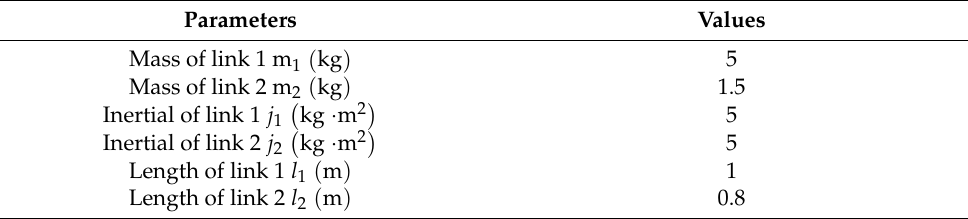
Table 1. Parameter of the robotic manipulator. Parameters